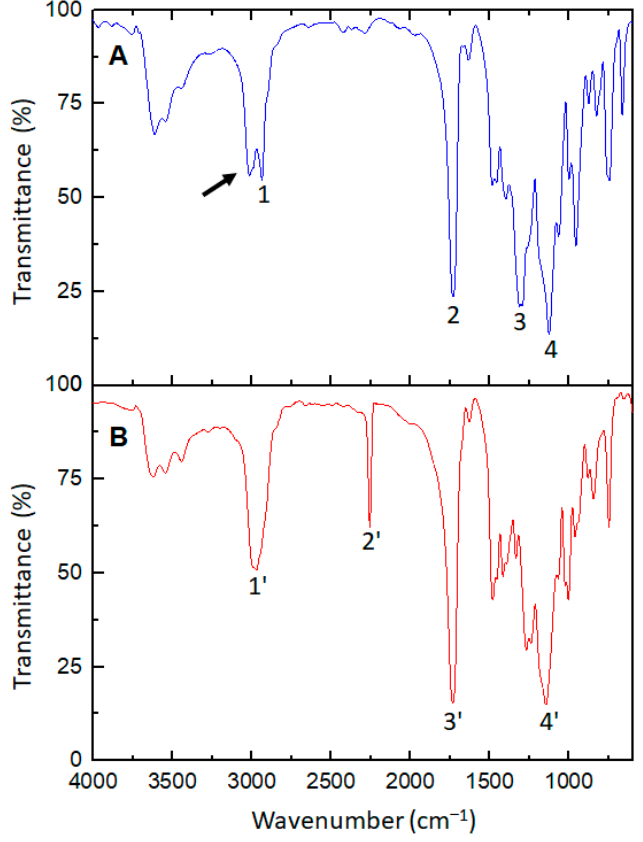
Figure 1. FTIR spectra of PSO 2 MA ( A ) and poly(2 − cyanoethyl methacrylate) (PCNMA) ( B ).